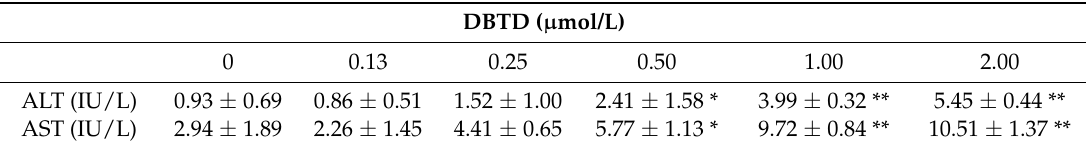
Table 1. Activities of alanine aminotransferase (ALT) and aspartate aminotransferase (AST) in the culture media measured by kits after treatment with different concentrations of DBTD for 24 h. DBTD (μmol/L)